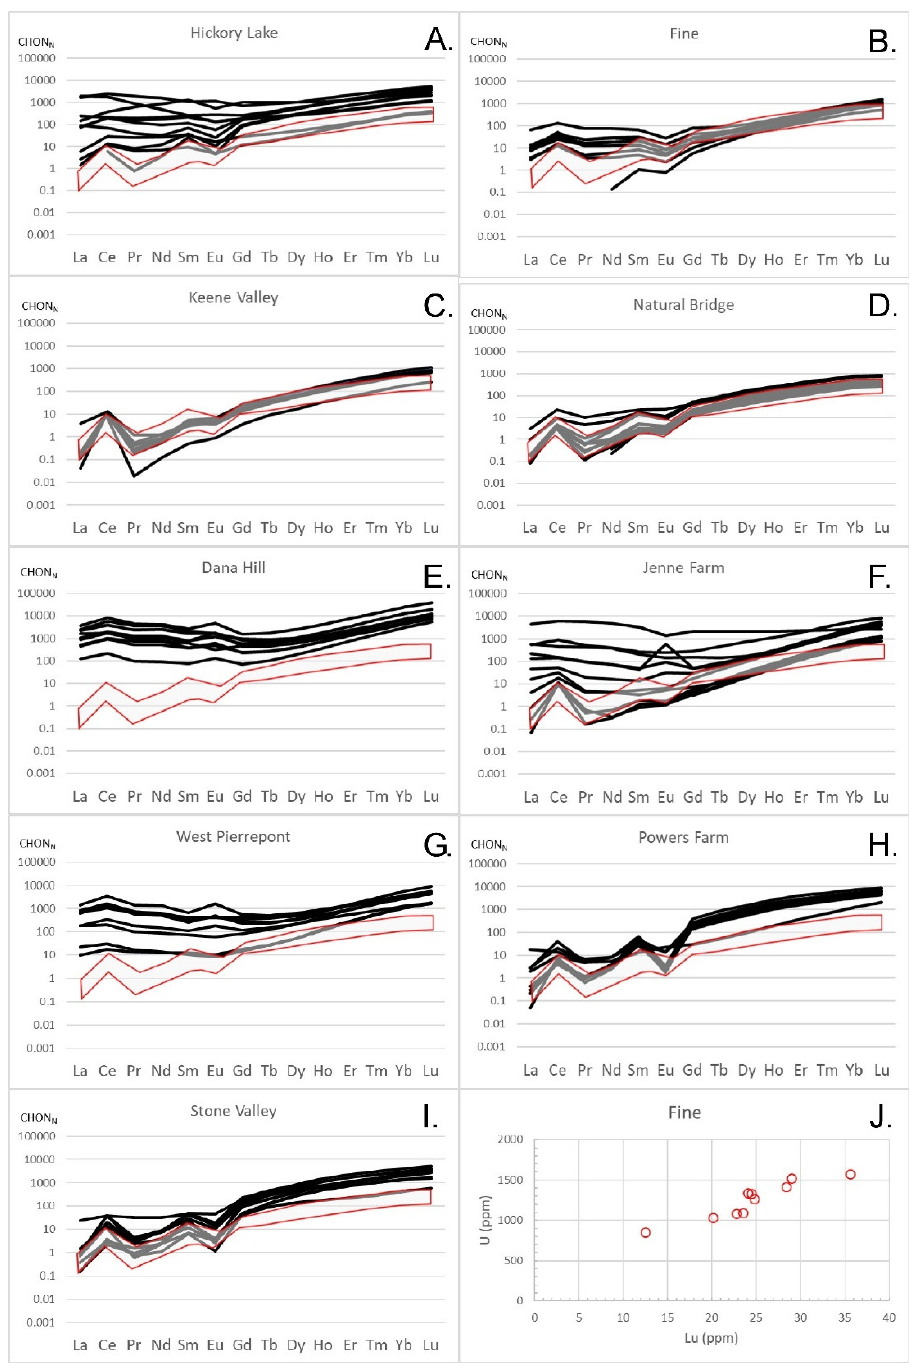
Figure 6. ( A – J ) Rare-earth element spidergrams for zircon samples in this study normalized to chondritic values (CHON N ) [29]. Continental zircon field (red outline) shown from Grimes et al. [28]. ( J ) Scatter plot of Lu versus U.